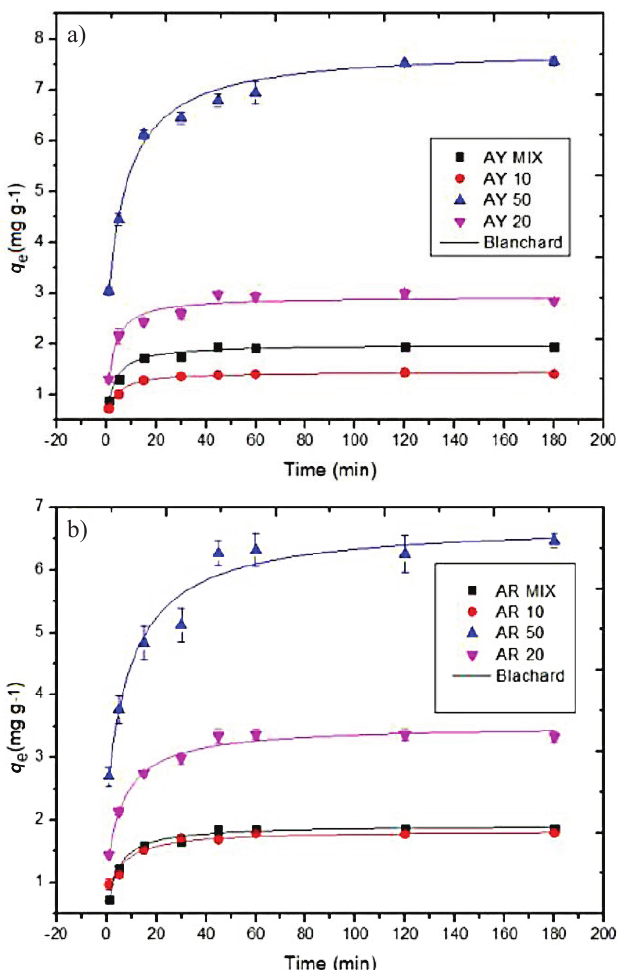
Fig. 5 – Biosorption kinetics of acid yellow and acid red dye using Açaí seeds powder with acid treatment performed at 20 °C and 100 rpm Note: AY MIX: Binary solution with 10 mg L –1 of acid yellow dye; AY 10: Single solution with 10 mg L –1 of acid yellow